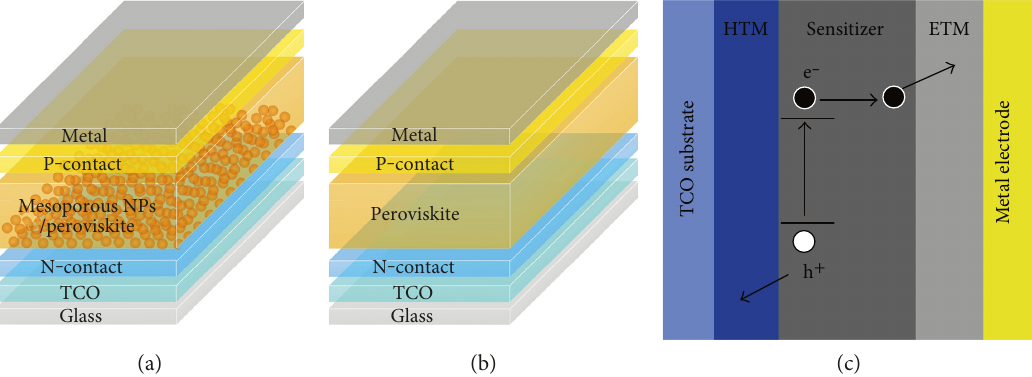
Figure 1: Device structures of (a) mesoporous structure, (b) n – i – p planar, planar junction structure, and (c) the scheme of carrier transport in PSCs.